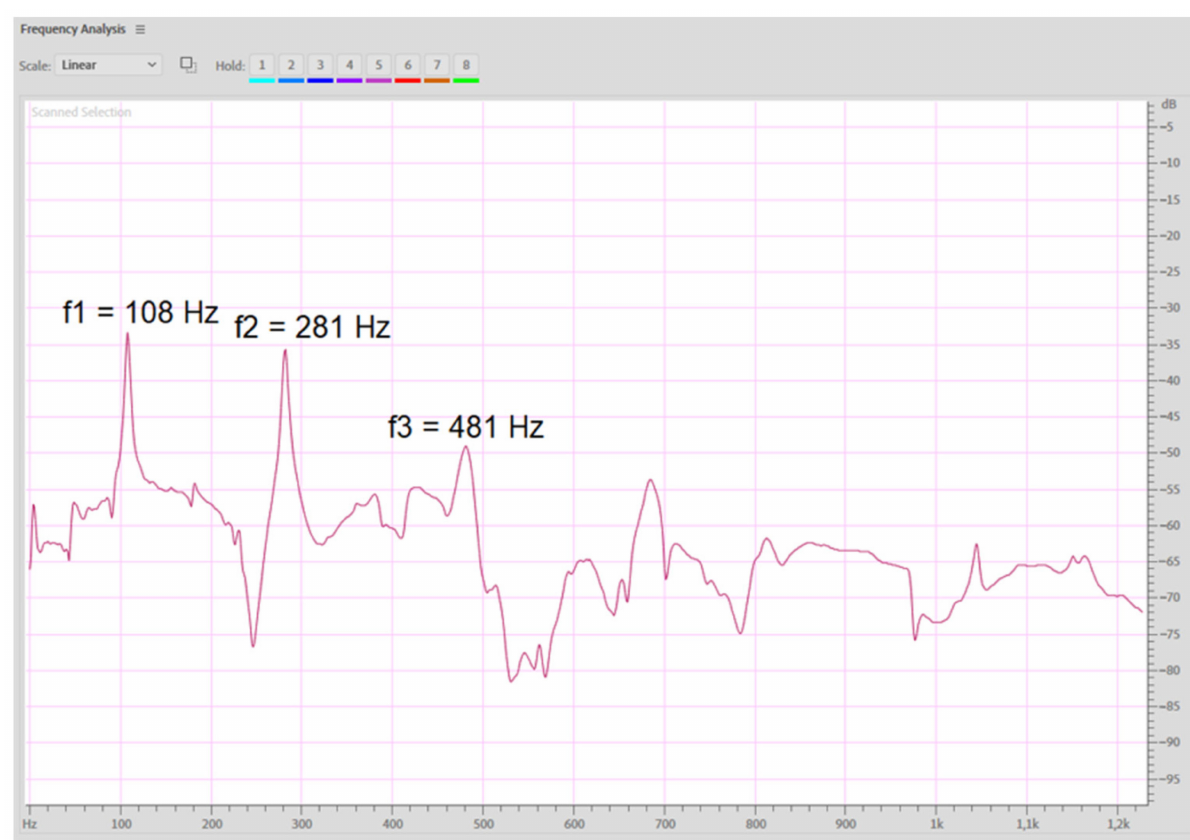
Figure 9. Oscillation diagram (spectrogram) of the test object